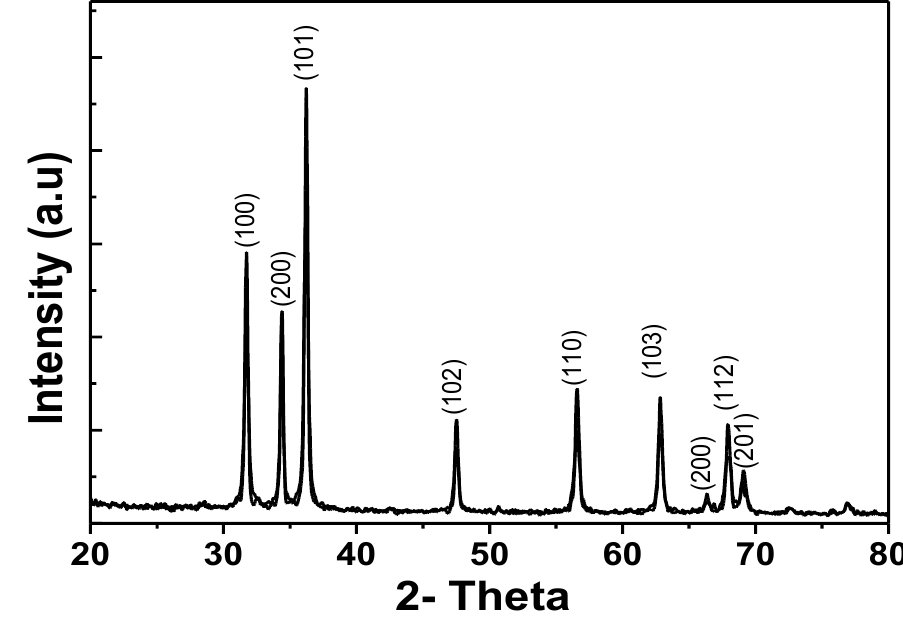
Figure 6. Results XRD patterns of ZnO.